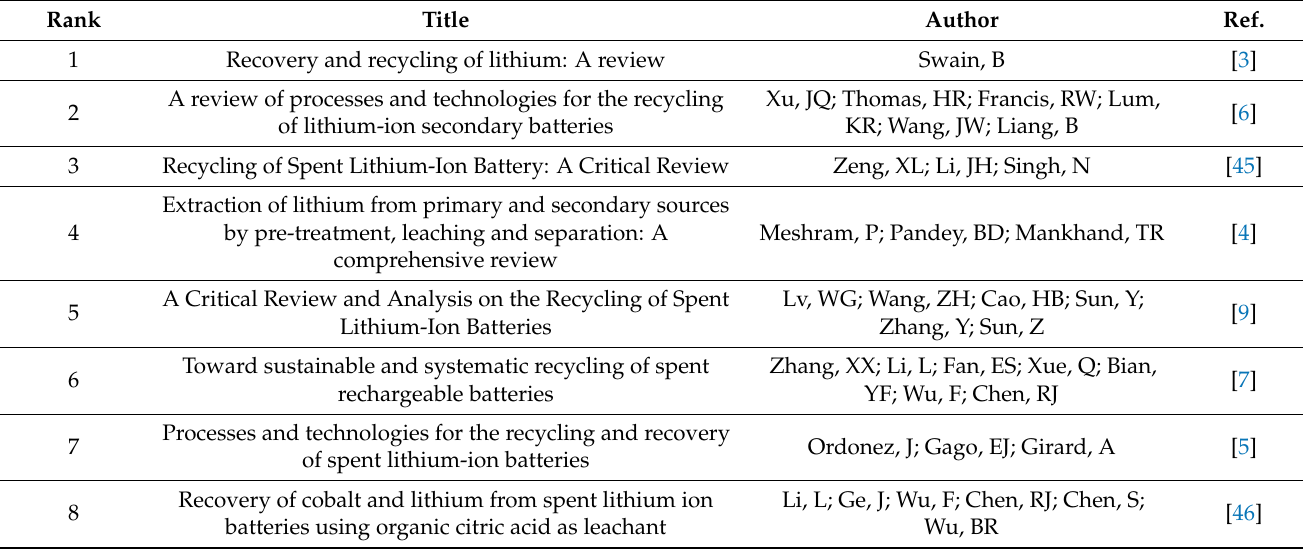
Table 4. List of the highest-ranking articles based on the Methodi Oridnatio